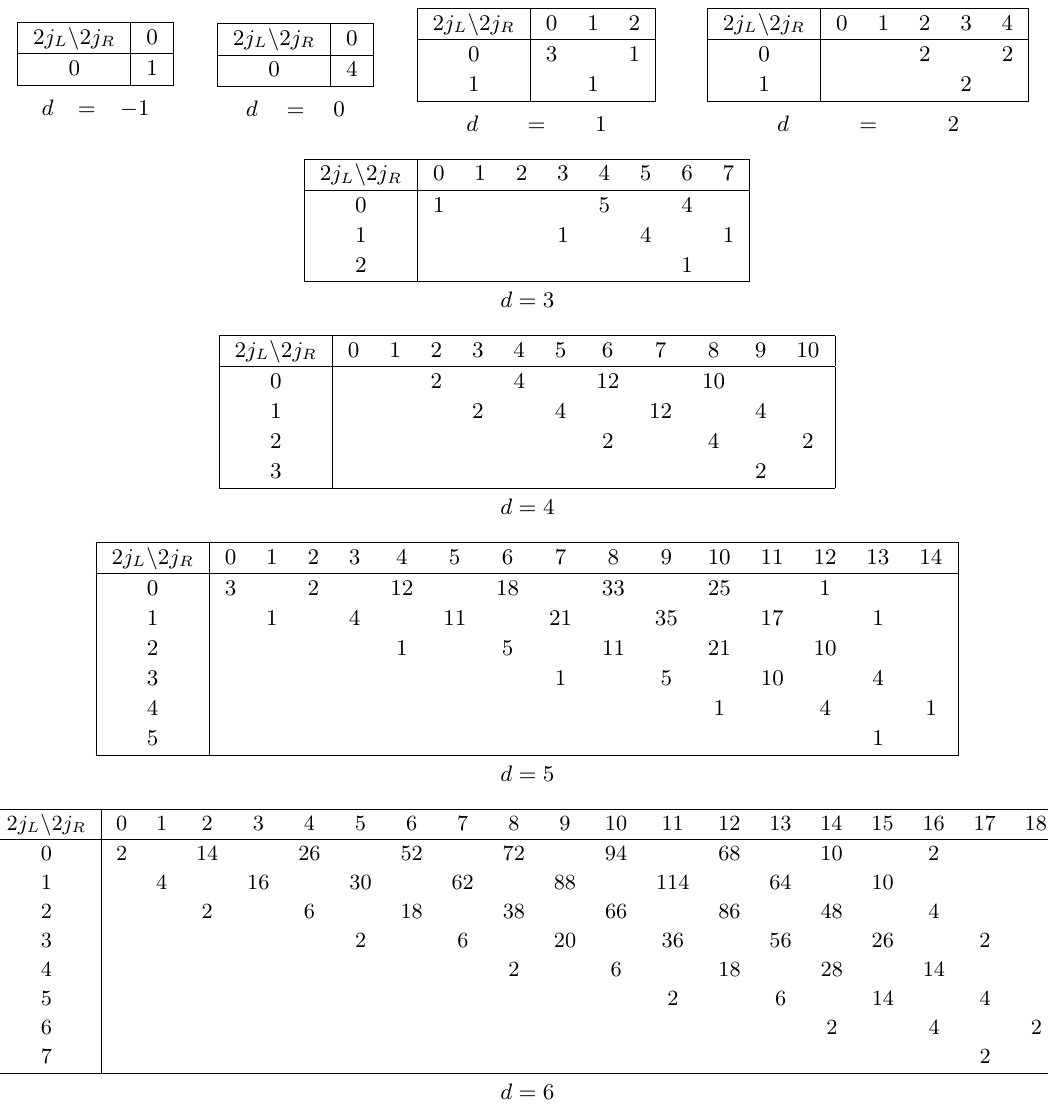
Table 11 . Pseudo-BPS spectrum of Wilson loop for local P 1 × P 1 in the representation 2 ⊗ 2 of SU(2) for the curve class dt = 2 dφ